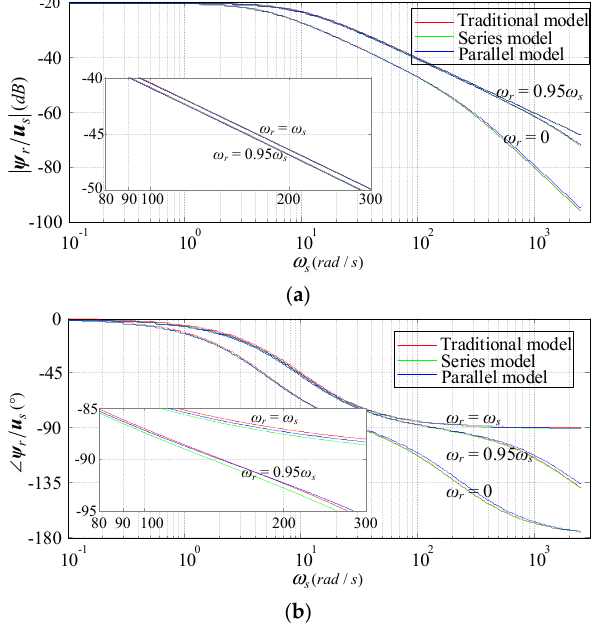
Figure 3. Bode plot of stator voltage excitation function. ( a ) Magnitude-frequency characteristic; ( b ) Phase-frequency characteristic.